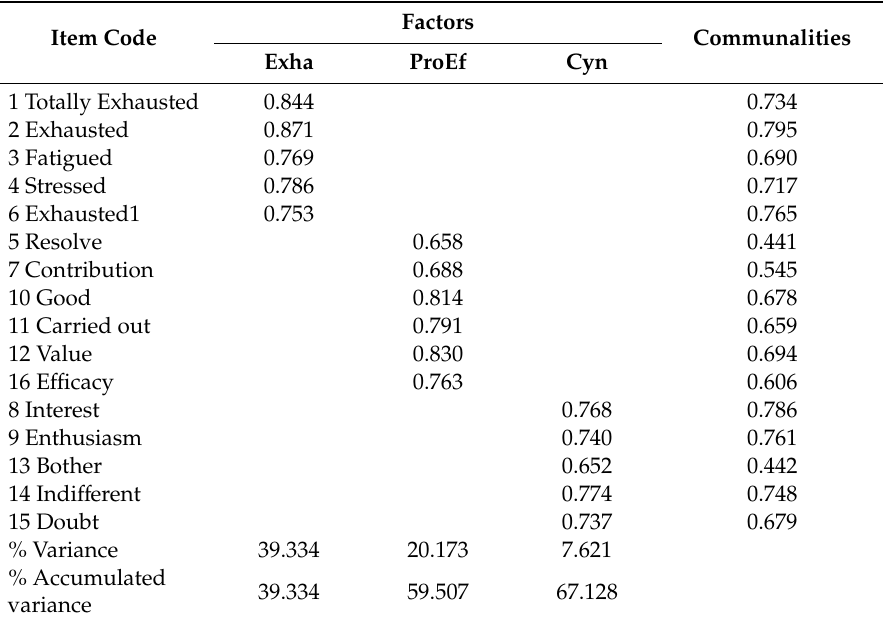
Table 2. Matrix of rotated component y